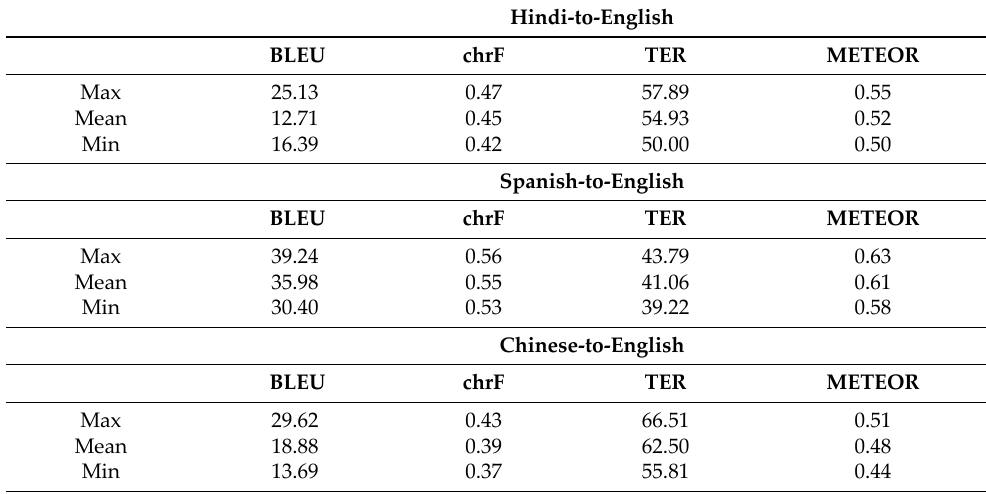
Table 7. Evaluation scores for the set of context‑sensitive